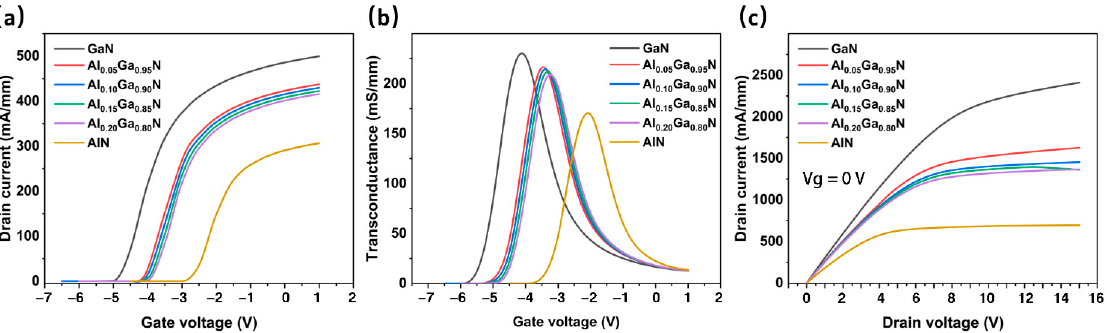
Figure 3. ( a ) Transfer characteristics, ( b ) transconductance, and ( c ) output characteristics of the HEMT with different buffer layers.